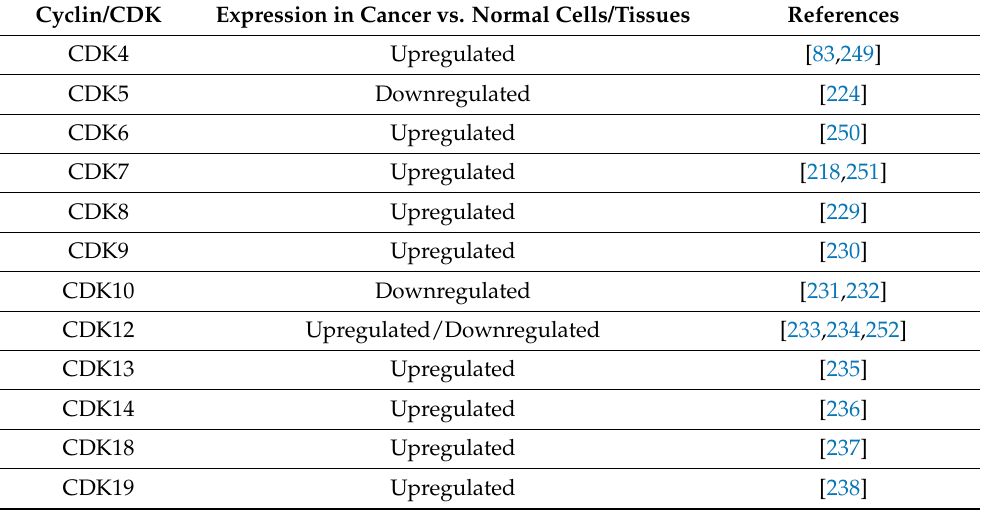
Table 9. Cont. Cyclin/CDK Expression in Cancer vs. Normal